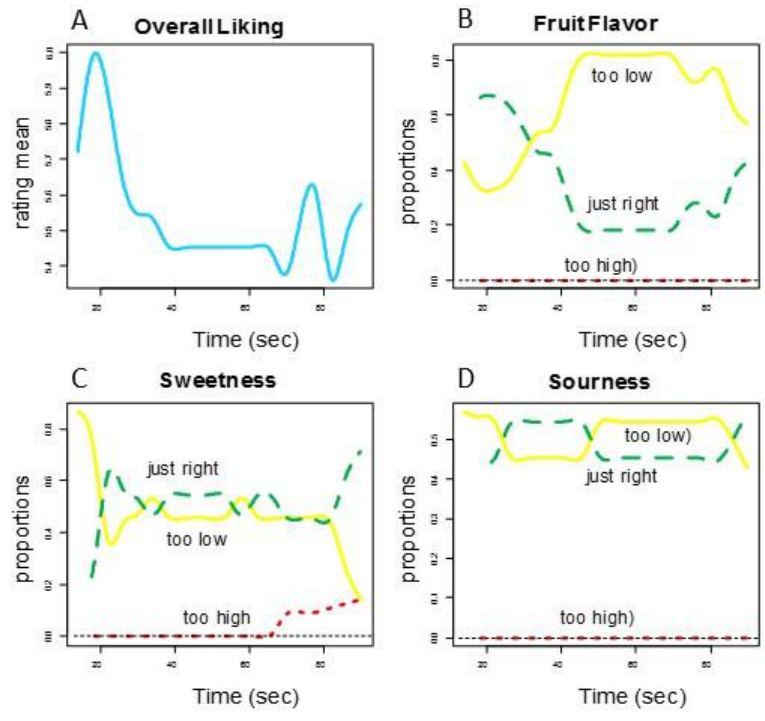
Figure 5. Consumer panel chew-down—smooth prototype ( A ) Overall Liking of Flavor, ( B ) Fruit Flavor, ( C ) Sweetness, and ( D ) Sourness just-about-right scales.